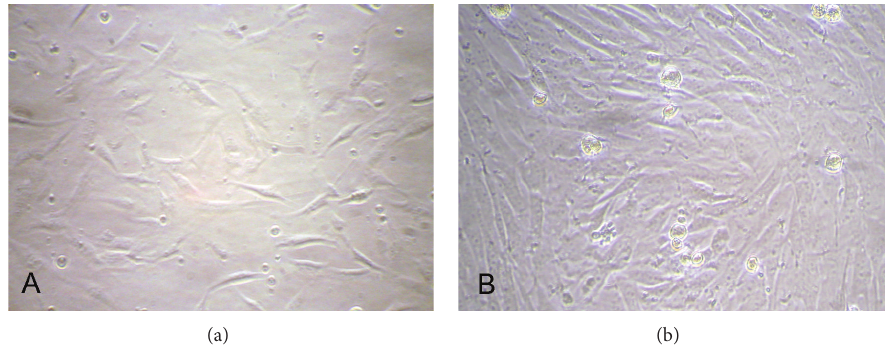
Figure 1: Morphology of Guinea pig fetal fibroblast cells in vitro: (a) primary cells and (b) near confluence.